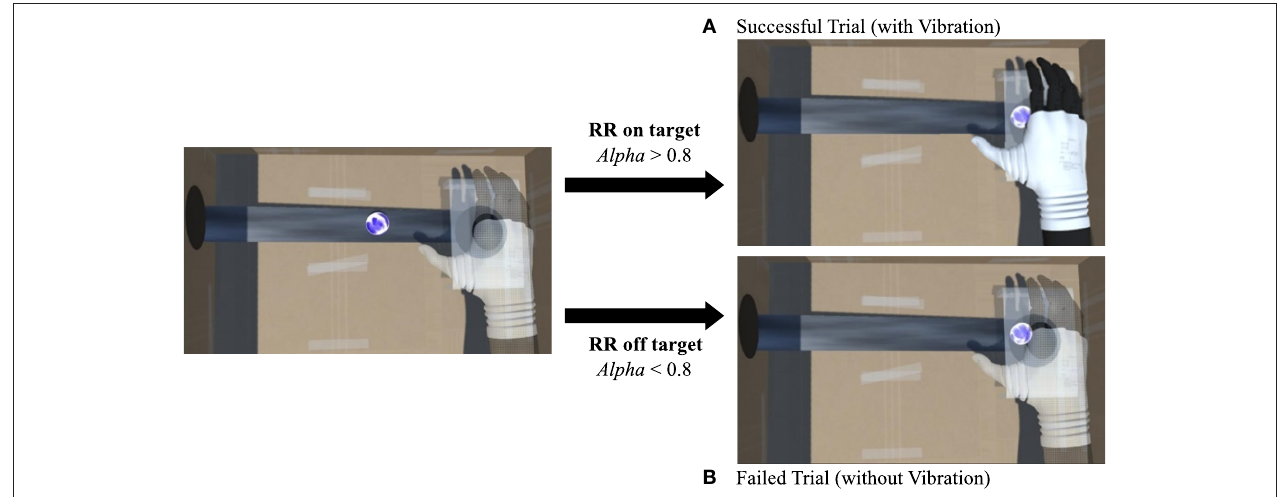
FIGURE 3 | Examples of (A) successful trial (the sphere reaches the virtual hand in fully visible state) and of (B) failed trial (the sphere reaches the virtual hand in transparent